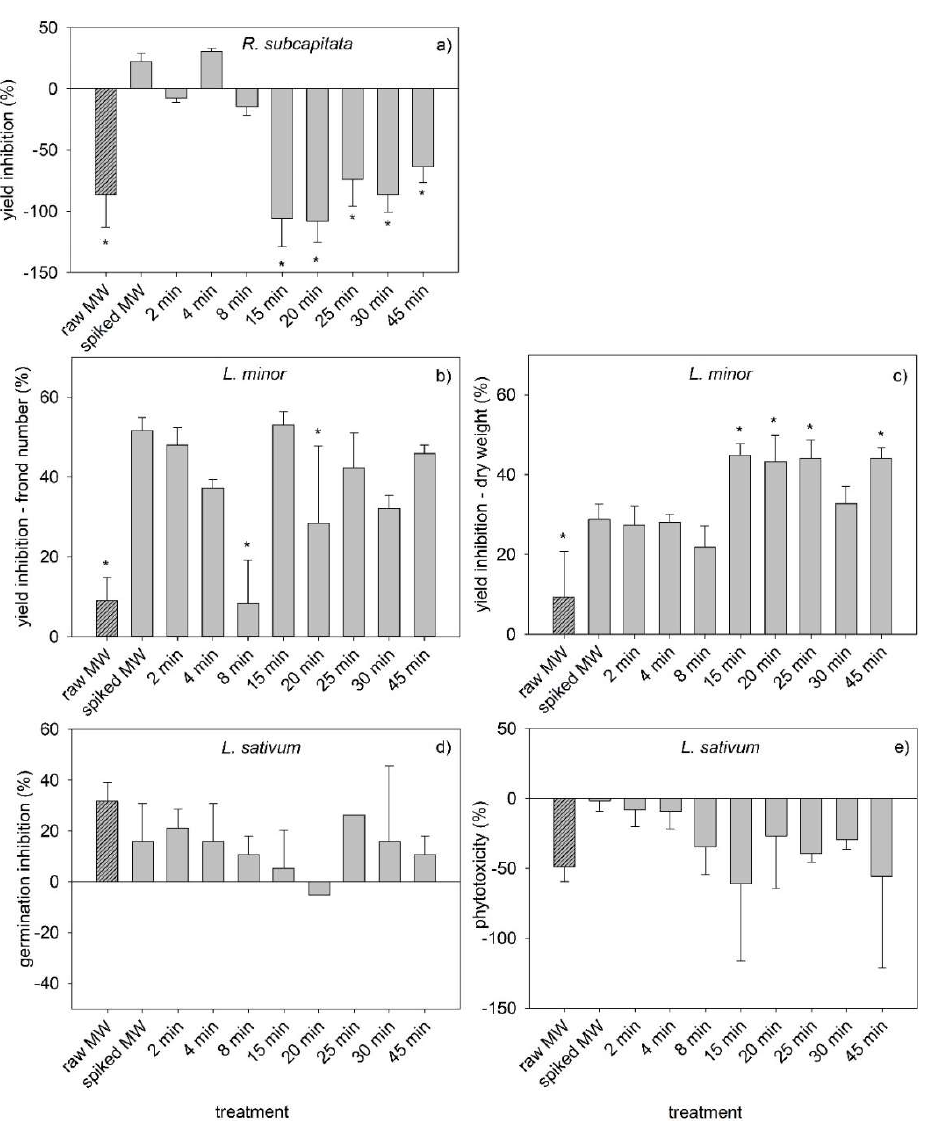
Figure 4. Toxicity response of several model species exposed to the raw municipal wastewater (raw MW, diagonal lines), and to the MW added five PPCPs (MP, PP, PCT, SMX and CBZ at 1 mg L −1 each) before ozonation (spiked MW) and after different periods of ozonation. ( a ) Yield inhibition of R. subcapitata after 96 h of exposure; ( b ) yield inhibition based on the frond number of L. minor after 7 d of exposure; ( c ) yield inhibition based on the dry weight of L. minor after 7 d of exposure; ( d ) germination inhibition of L. sativum after 48 h d of exposure; and ( e ) phytotoxicity of L. sativum after 48 h of exposure. Bars represent the mean and the error bars represent the standard deviation. Asterisks represents significant differences relative to the untreated spiked MW.